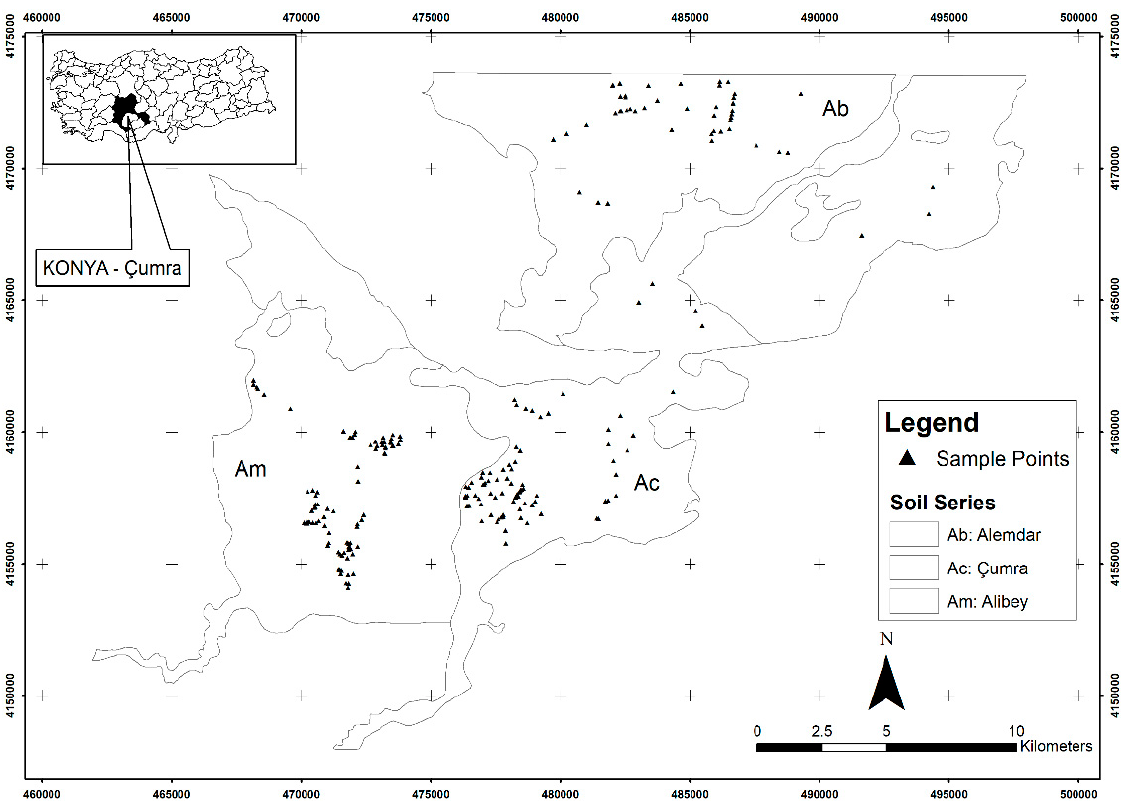
Figure 1. Map of soil sampling locations in the study area. All the soil samples were collected from 0–20 cm soil profiles and taken from at least five points in each plot. These five samples were combined to form a representative sample. These samples were air-dried under laboratory conditions, passed through